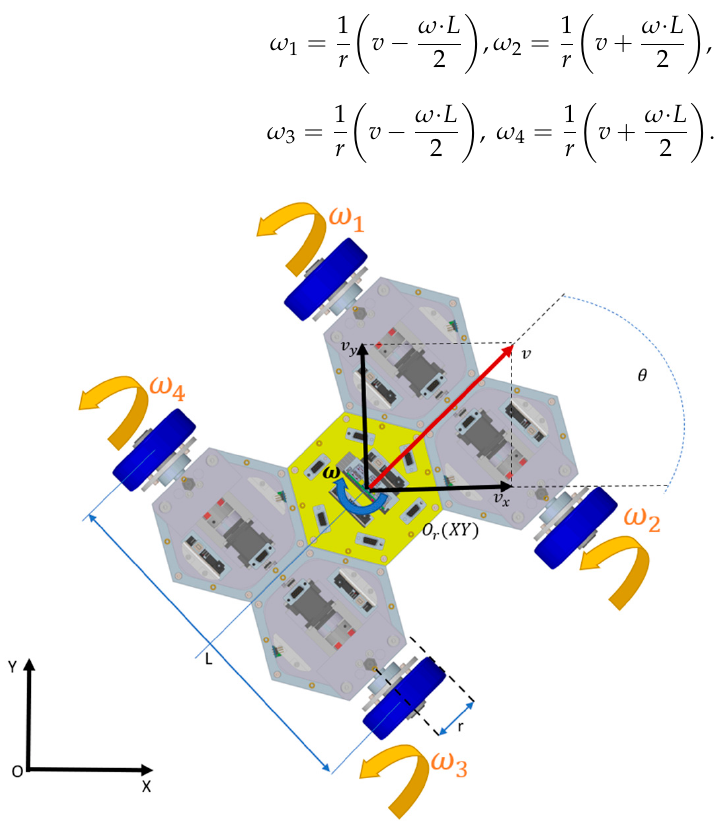
Figure 25. Schematic kinematic model of the modular mobile robot with differential traction. The inverse kinematics is necessary for the actuation of the robot’s body along a certain trajectory, resulting in inertial forces. Direct kinematics is necessary for the actuation of the wheels, from where the value of the inertial forces acting on the wheels during actuation can be found. Using the Jacobian matrix given by Equation (11), all resistive forces were transposed to the drive wheels to determine the torque variation during the movement of the mobile robot according to Equation (12).